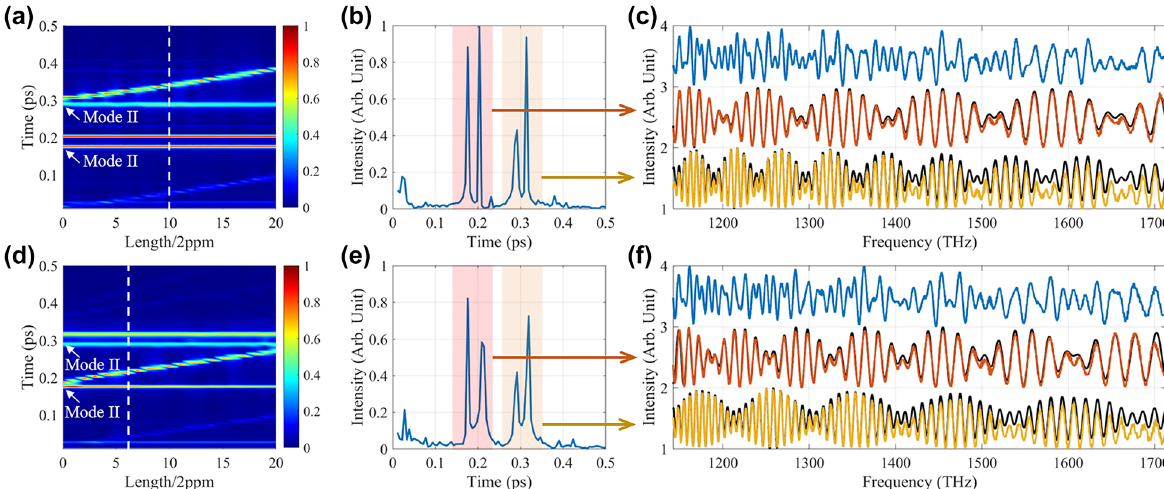
Figure5: Experimentalenvelopemultiplexingmodulationoftwosetsofcoupledresonatorswith(a)a fi xedairresonatorlengthof ∼ 13.2 μ min the thin PDMS resonator group, and we changed air resonator length in the thick PDMS resonator group. (b) A typical spectral component in the reciprocal space corresponds to the dashed white line in (a), where the air resonator length changes 12.5 μ m. (c) The blue curve corresponds to experimental re fl ections from two coupled resonators. The curves with red and orange are the measured re fl ections individually,andtheblackcurvesarethedemodulatedsignalsviaextractingthemodecomponentsinsidethewindowof(b).(d) – (f)maintaina similar meaning to (a) – (c). In (d),the fi xed air resonatorlength was ∼ 8.3 μ m in the thick PDMS resonatorgroup,and we changed air resonator length in the thin PDMS resonator group. (e) A typical spectral component in the reciprocal space corresponds to the dashed white line in (d), where the air resonator length changes 7.5 μ